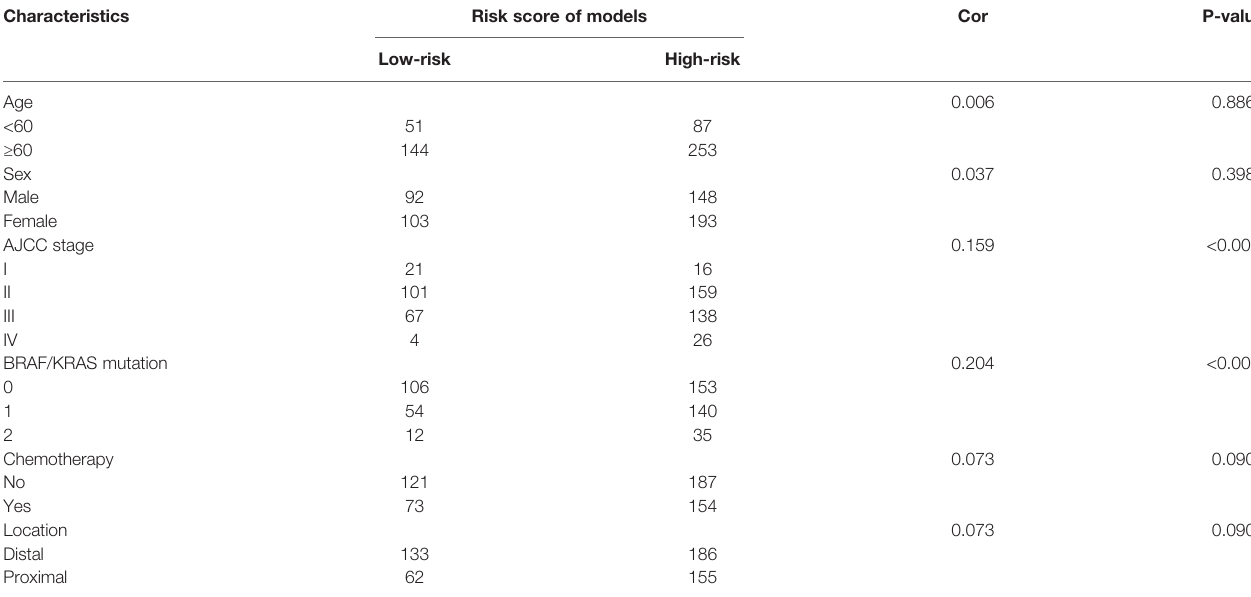
TABLE 2 | Correlations between relapse model and clinicopathological characteristics in the GSE39582 dataset. Characteristics